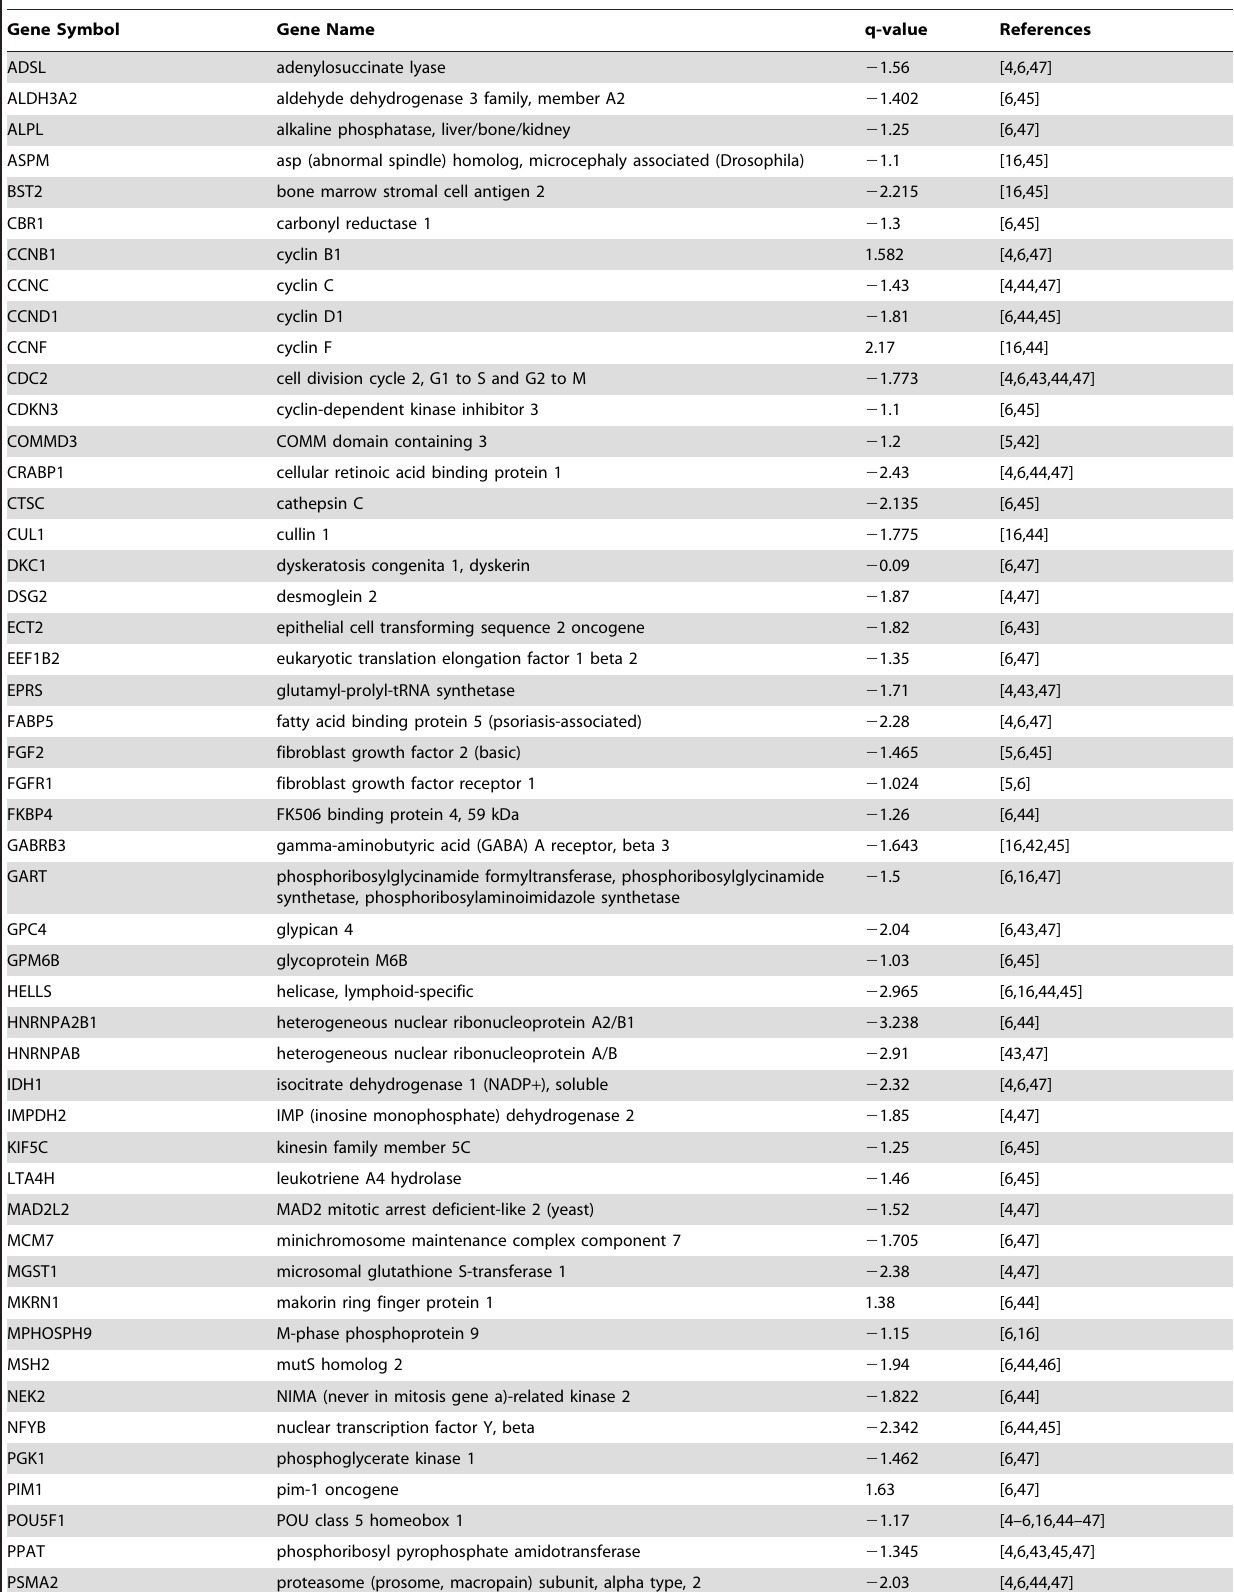
Table 3. Altered expression pattern of known markers of